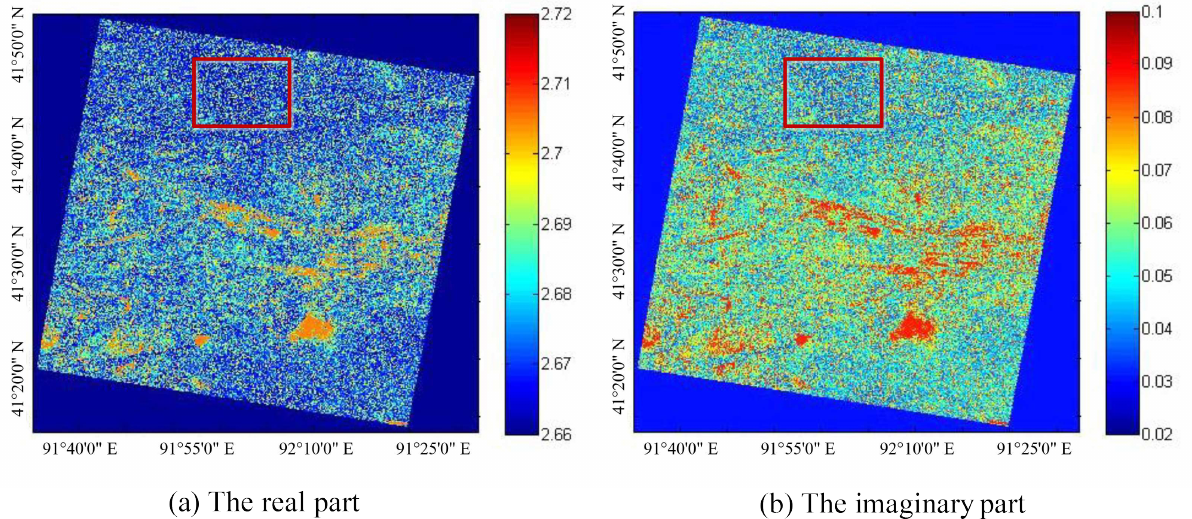
Figure 7. The dielectric constant map of the test site. ( a ) The real part. ( b ) The imaginary part. The calculated dielectric constant is then used to invert the penetration depth, i.e., ∆ h errPen of L band, which is shown in Figure 8. It can be found that the corresponding penetration depth values of the L-band are mainly between 0 and 1m in the area covered by rocks; for the sand region, the corresponding penetration depth are mainly in the range of 1 to 2 m, and the average value in the red rectangle region is 1.295 m.